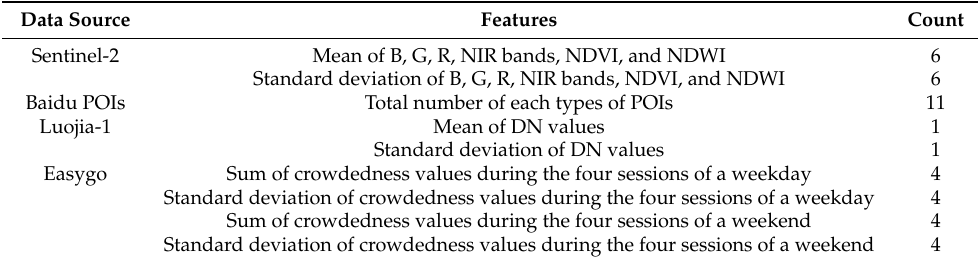
Table 4. Summary of